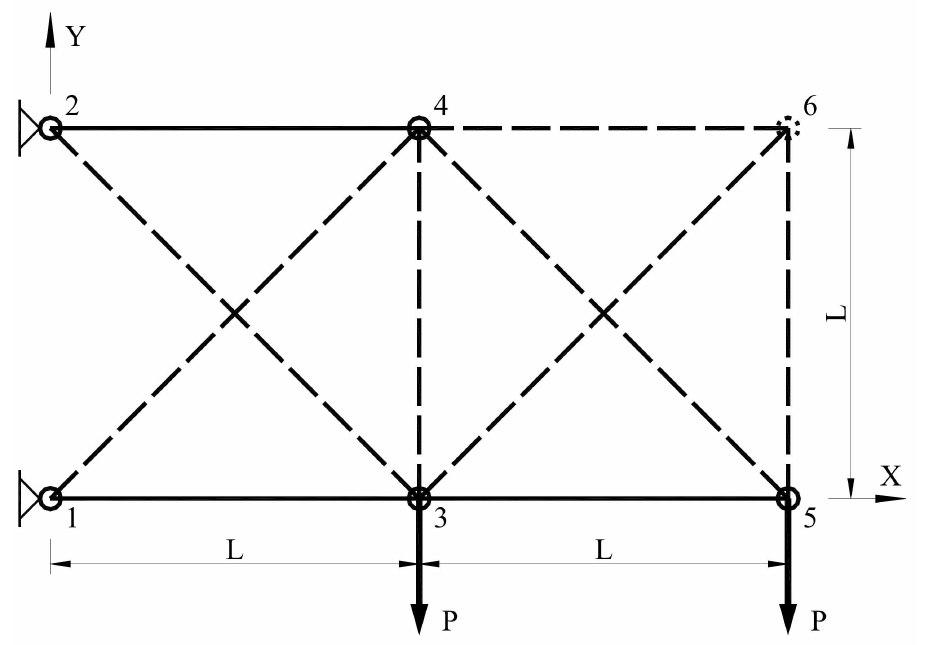
Figure 6. Fixed and alternative structural